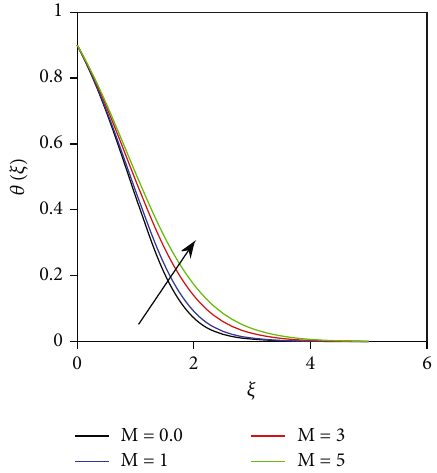
Figure 3: Temperature pro fi les for magnetic fi eld parameter M